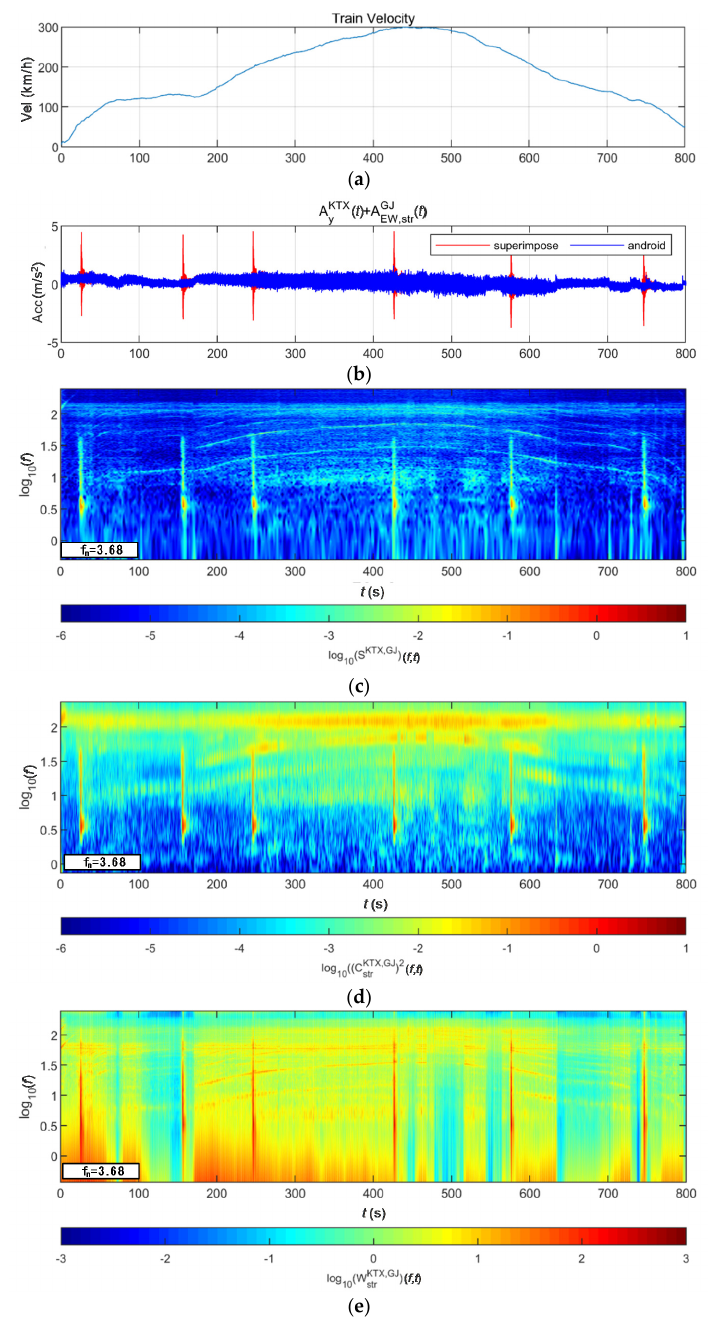
Figure 35. Combination of train data with BR3 bridge-response data from the Gyeongju earthquake (scaled to 2400-year return period): ( a ) velocity; ( b ) lateral acceleration time series; ( c ) STFT; ( d ) WT; ( e ) WVD.